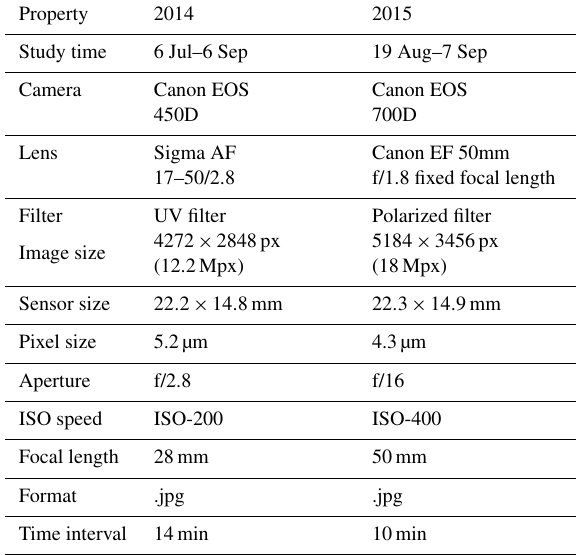
Table 1. Time-lapse camera properties for 2014 and